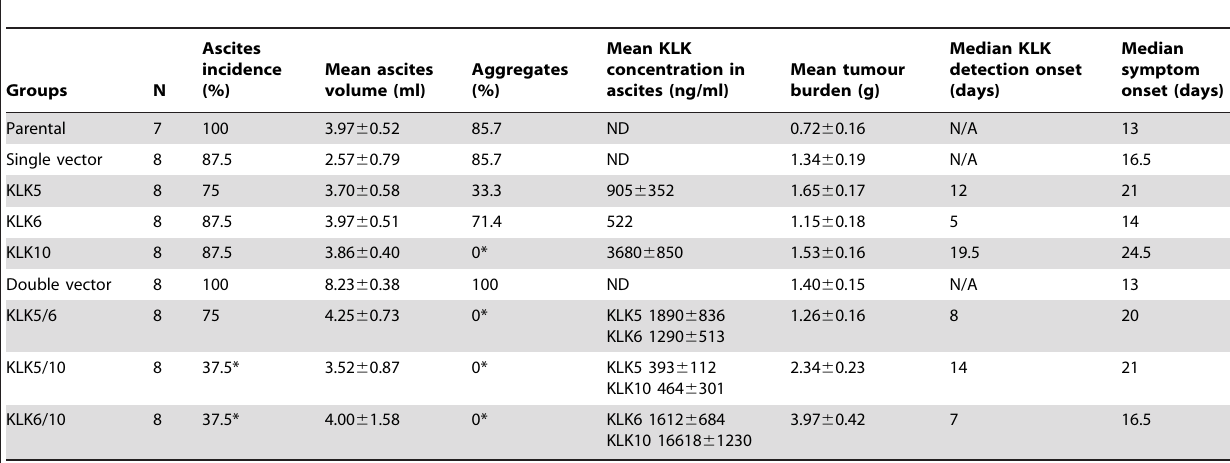
Table 3. Nude mice xenografted with ES-2 derived clones overexpressing KLK5, 6 and 10 alone or in pairs, develop different